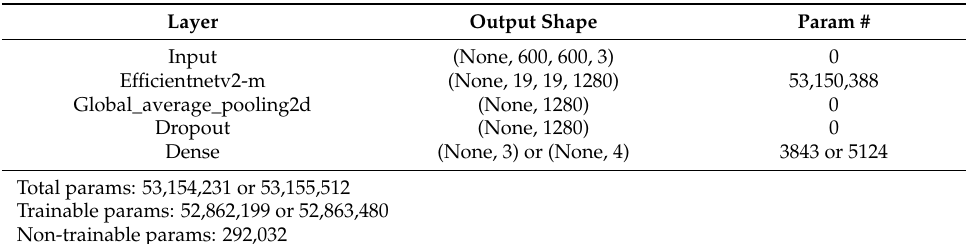
Table 6. Our target model trained on a complete model (base model and new top layers) of the NIH or SCH data set.